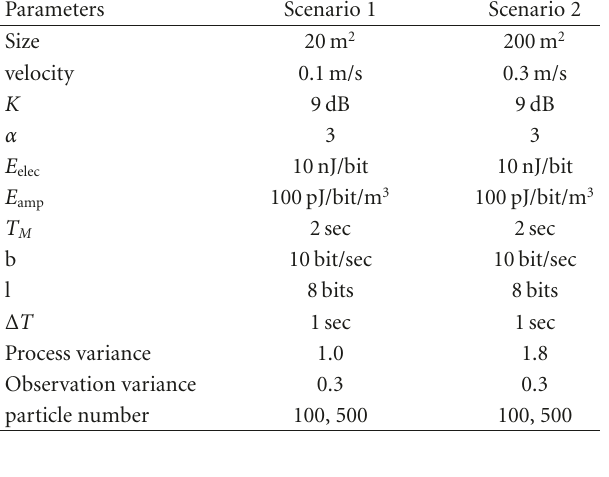
Table 3: Parameters of the model used for simulations. Parameters Scenario